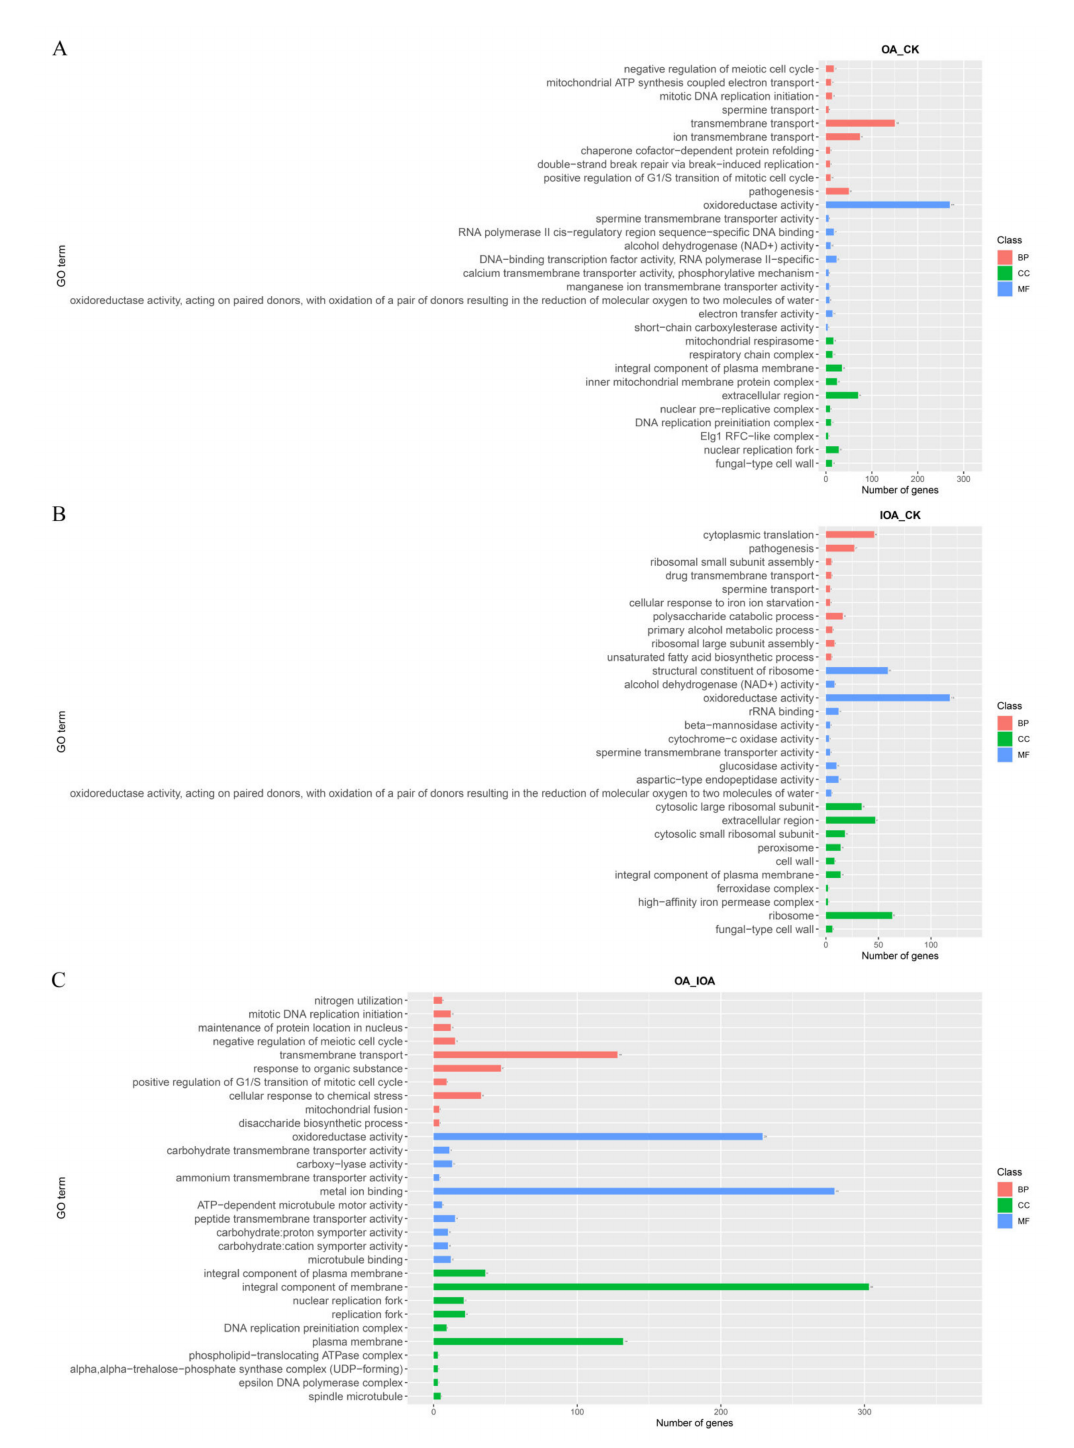
Figure 2. GO database enrichment analysis of DEGs in mycelia between the three treatments. The GO classification map of the ( A ) OA vs. CK, ( B ) IOA vs. CK, and ( C ) OA vs. IOA